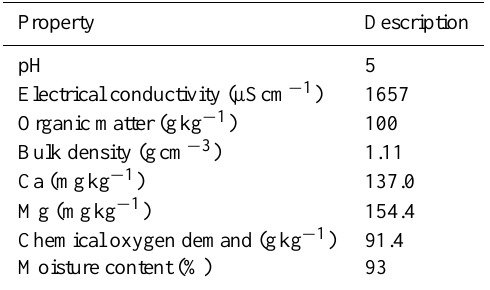
Table 2. Chemical characteristics of vinasse applied in the